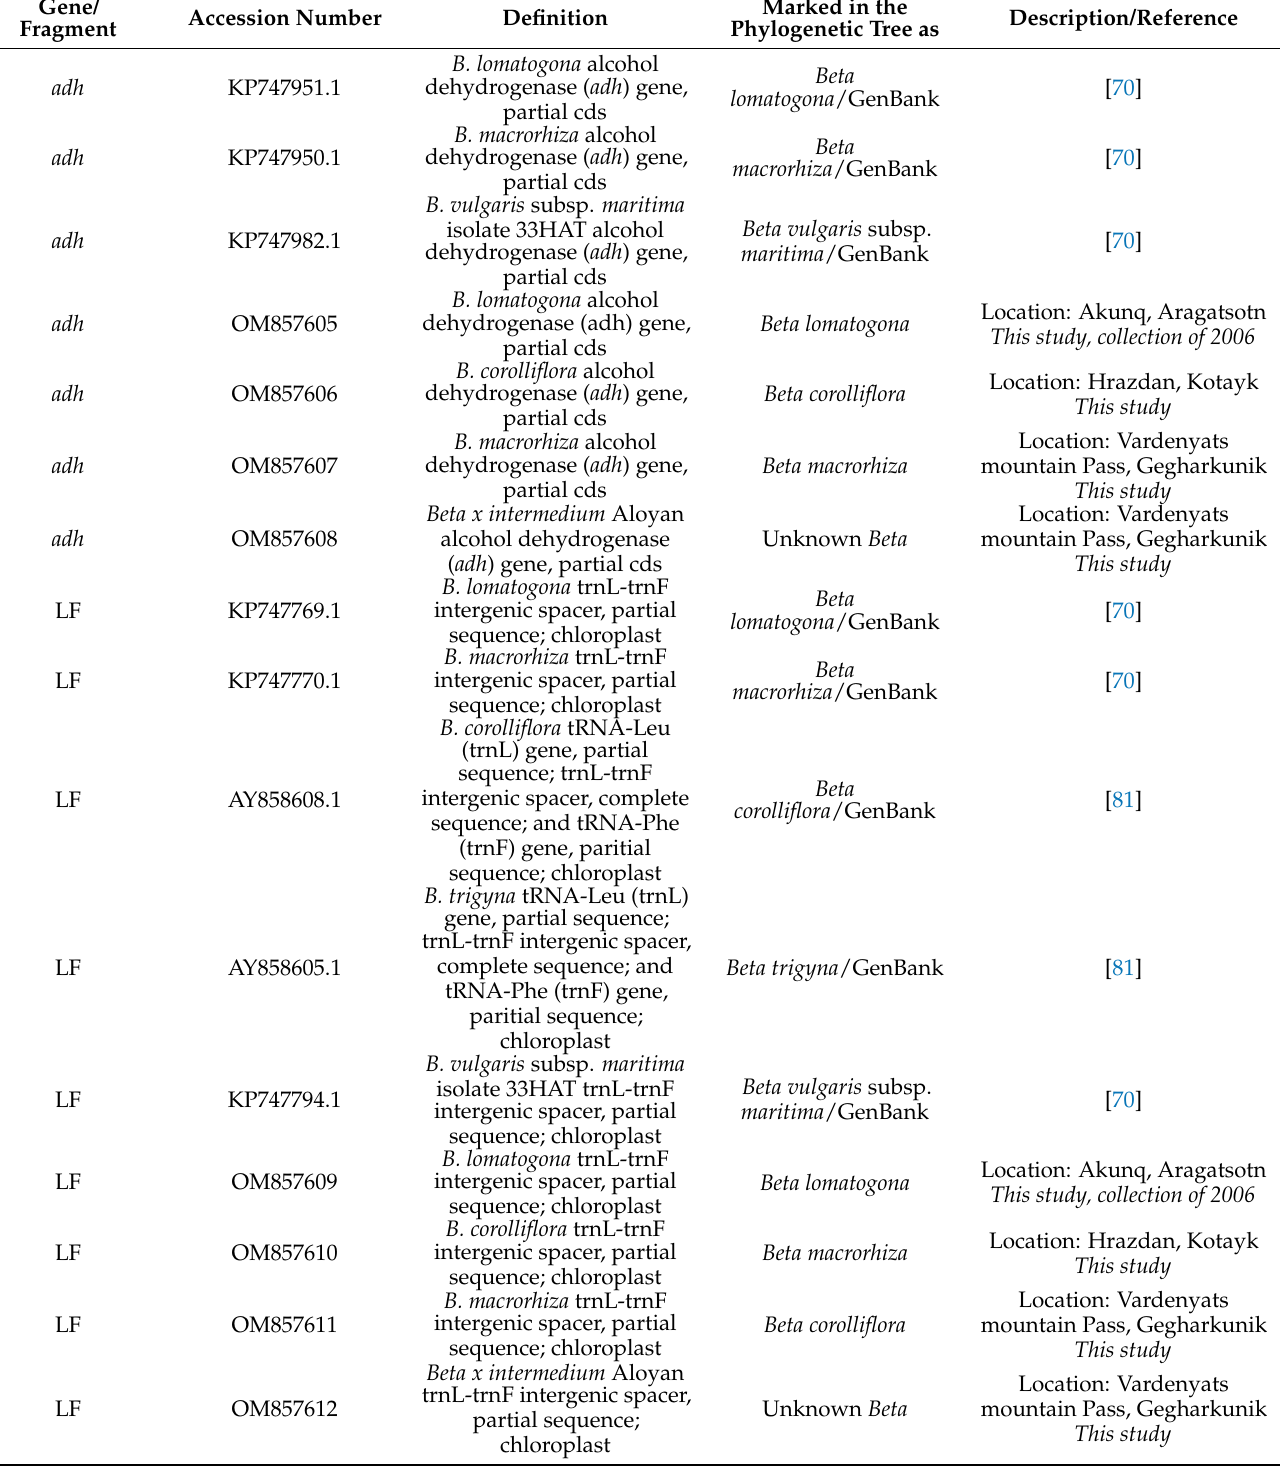
Table 5. List of DNA fragments used for construction of phylogenetic